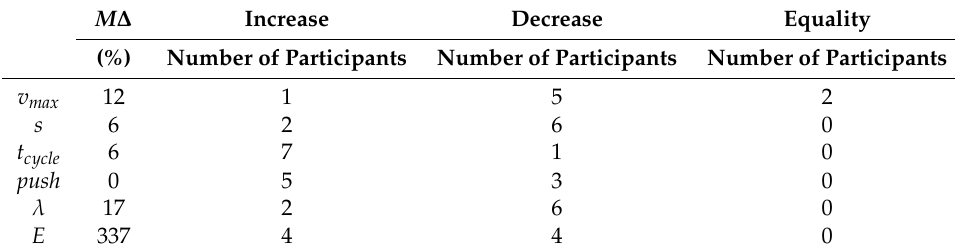
Table 5. The comparison of the average percentage di ff erence in the values of the tested parameters M ∆ —a percentage di ff erence in the average values of a selected kinematic parameter resulting from the activation of the anti-rollback system, increase—the number of participants in which the analyzed parameter was higher with the activated anti-rollback system than with the deactivated anti-rollback system, decrease—the number of participants in which the analyzed parameter was lower with the activated anti-rollback system than with the deactivated anti-rollback system, equality—the number of participants in which the analyzed parameter was equal with the activated anti-rollback system and with the deactivated anti-rollback system.